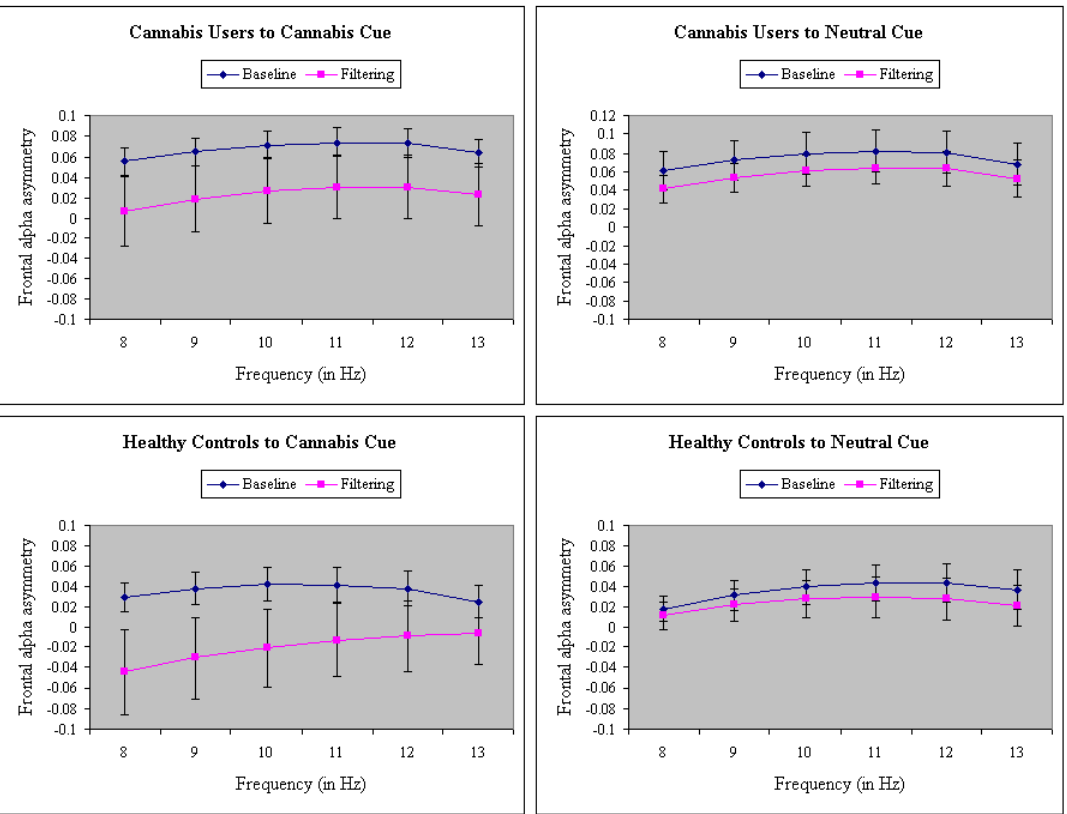
Figure 3. A significant four-way interaction in group (cannabis users vs. controls), task (baseline vs. filtering), cues (cannabis vs. neutral) and frequency (8–13 Hz) on frontal alpha asymmetry. Control participants show right-sided hemisphere (avoidance) frontal alpha asymmetry (FAA) activation only to cannabis cues during the filtering task, and they show left-sided (positive) activation in the other conditions, while cannabis users show left-sided activation (approach) in all conditions. Error bars represent the standard error of the mean.